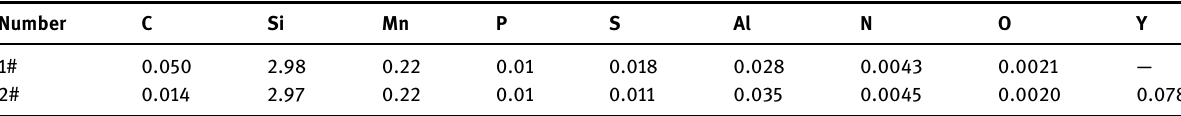
Table 1: Chemical composition of analysis of 3% grain - oriented electrical steel ( mass fraction, % )